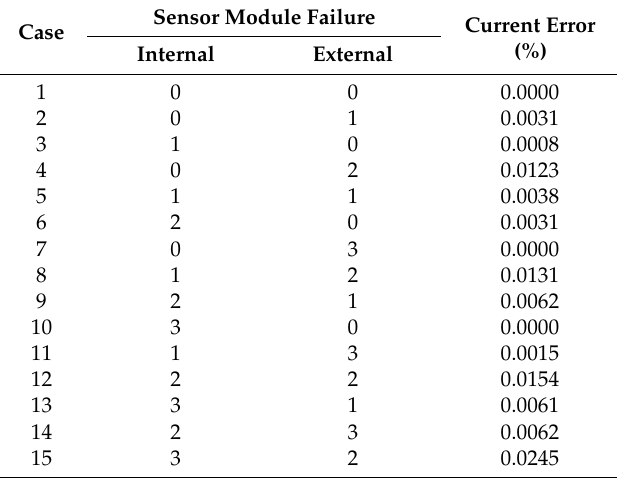
Table 2. Current errors of the proposed HCT with double-layer sensing structure in different sensor module failure situations.